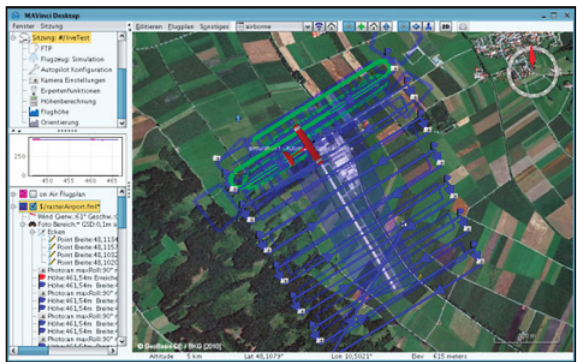
Fig. 4. Flight planning with picture area from MAVinci Desktop flight planning software (Images … 2011)